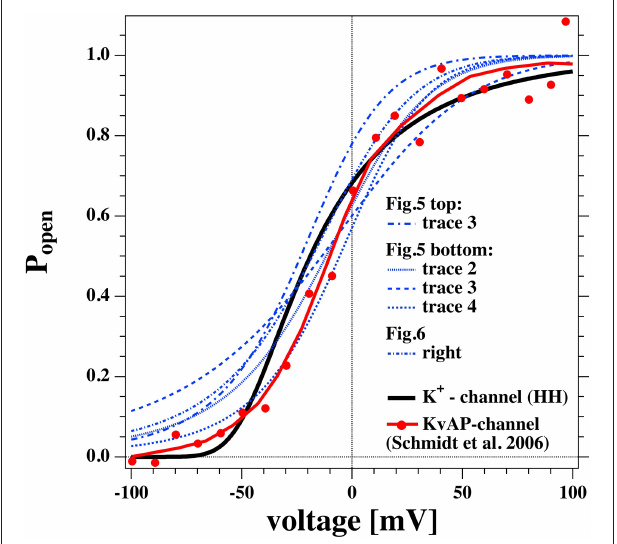
FIGURE 13 | Comparison of the open probability of the K + -channel of Hodgkin and Huxley (1952a) (fat line), the KvAP channel reconstituted into a POPE/POPC = 3:1 membrane (Schmidt et al., 2006) (fat red line and symbols), and selected open probabilities from Figures 7 , 8 in the voltage regime of physiological